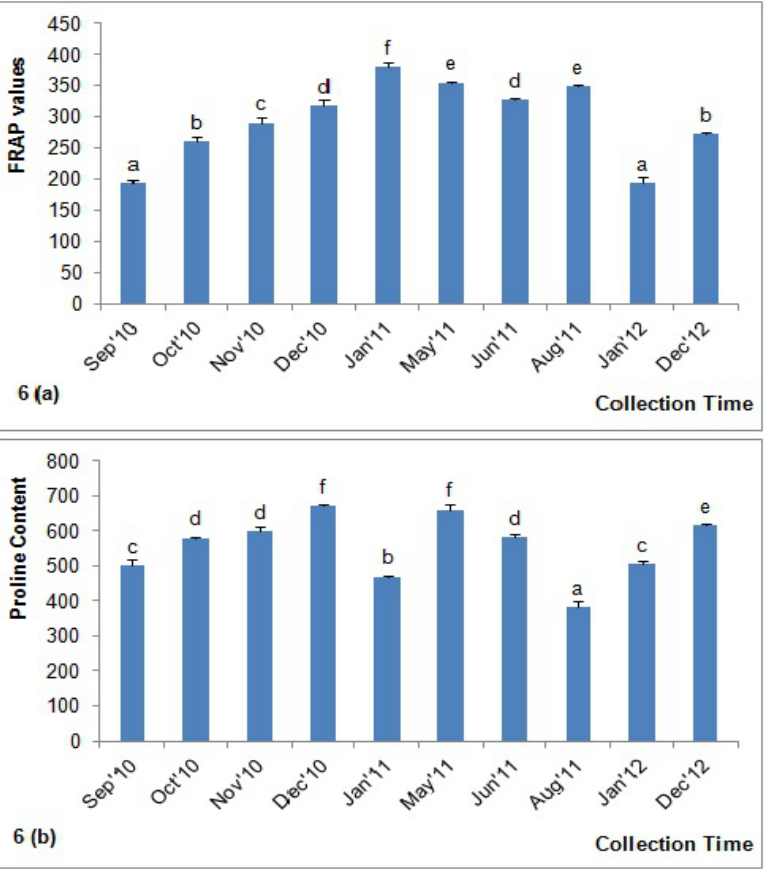
Figure 6. ( a ) FRAP values and ( b ) proline content of the Malaysian Acacia honeys. Values with different letters indicate significant differences ( p <